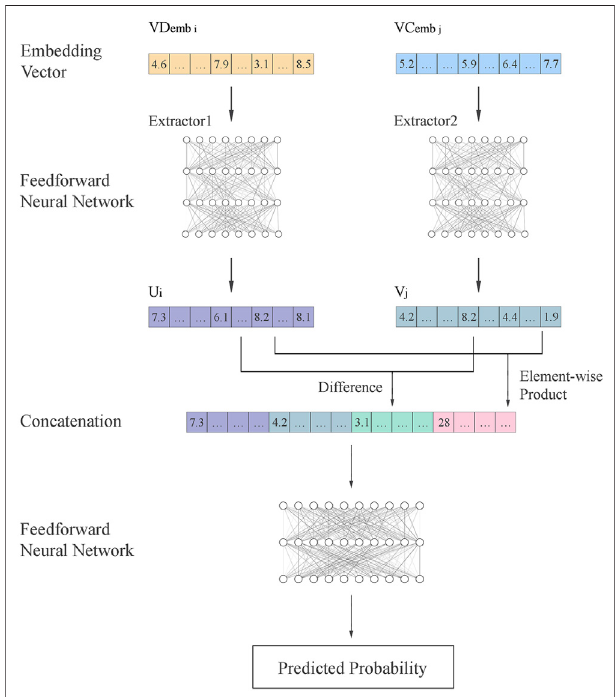
FIGURE 3 | Flowchart of Pseudo-Siamese network. Two feedforward neural networks are used as the extractor to extract features u and v from the embedding vector VD emb and VC emb . The difference and element-wise product of u and v are concatenated with u and v for analyzing association by a Feedforward neural